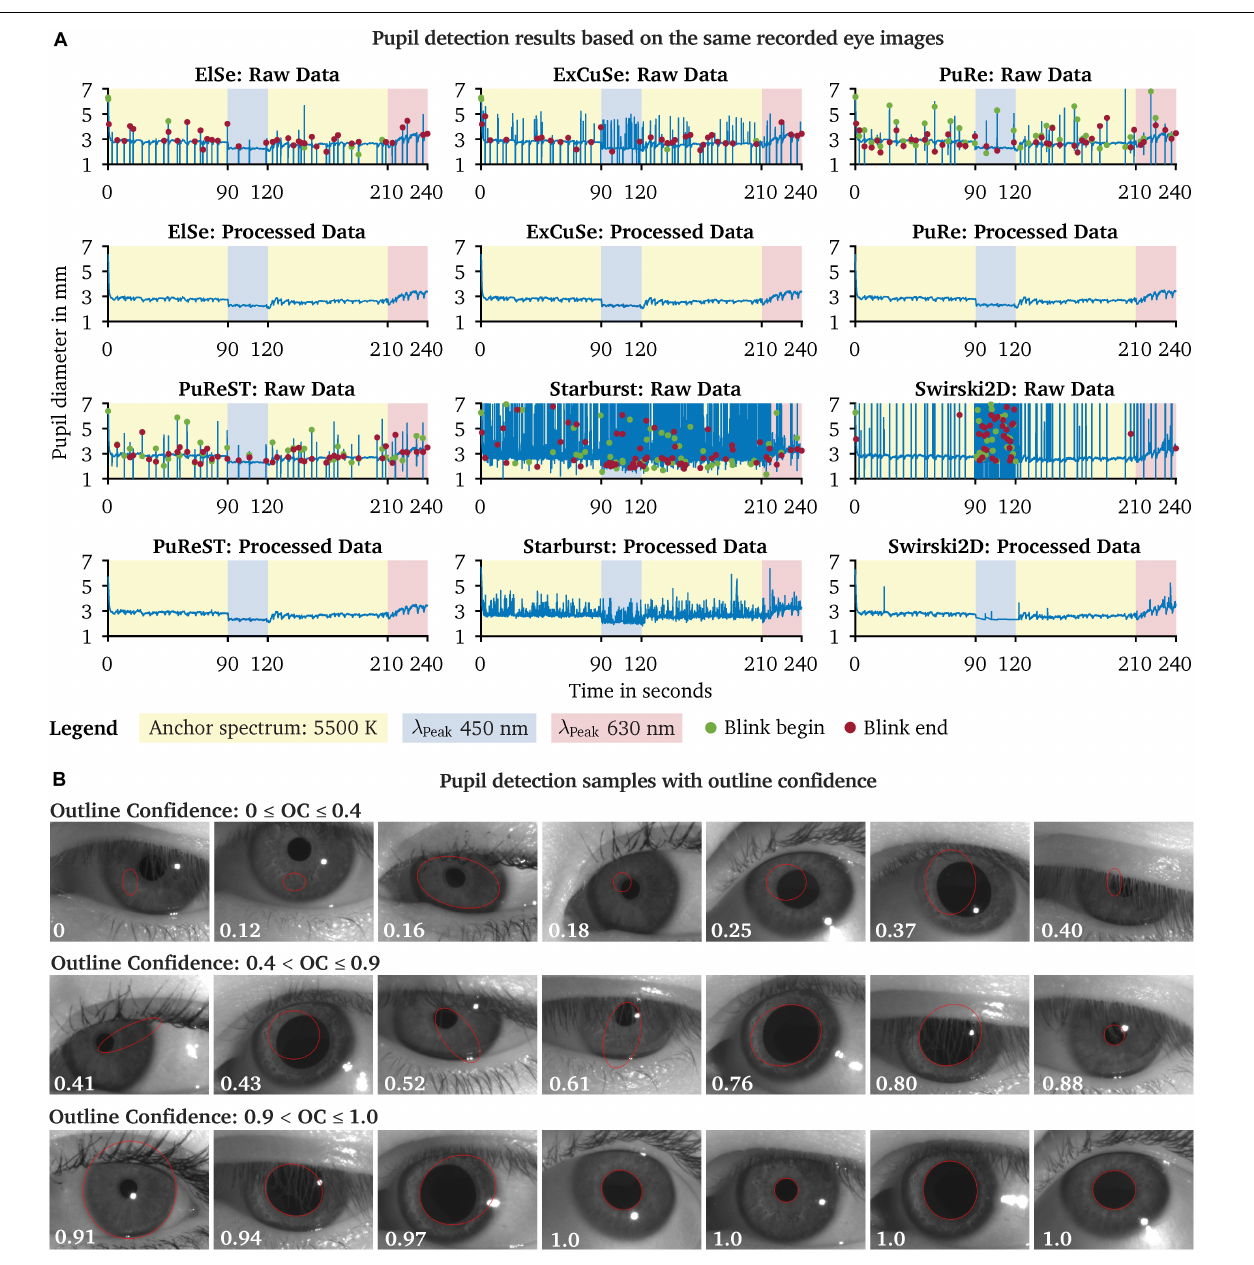
FIGURE 9 | Comparison of the pupil detection algorithms based on the same eye image set and visualization of the pupil ellipse fit as a function of the outline confidence. (A) Eye images from one subject were recorded during a chromatic pupillometry experiment using PupilEXT . The pupil was exposed to LED spectra of the peak wavelengths 450 nm (L = 100.4 cd/m 2 ± SD 0.23) and 630 nm (L = 101 cd/m 2 ± SD 0.31) for 30 s. An anchor spectrum with a correlated color temperature (CCT) of 5,500 K (L = 201 cd/m 2 ± SD 0.48) was turned on for 90 s between each stimulus. The pupil diameter from the recorded images was extracted using the available algorithms in PupilEXT and pre-processed to illustrate the algorithms’ detection differences. (B) For each detected diameter, an outline confidence measure is provided and used as an indicator to filter unreliable pupil fits from the dataset. Pupil fits from different measurement sessions are illustrated as a function of the outline confidence. We recommend discarding all pupil diameters with a lower outline confidence measure of